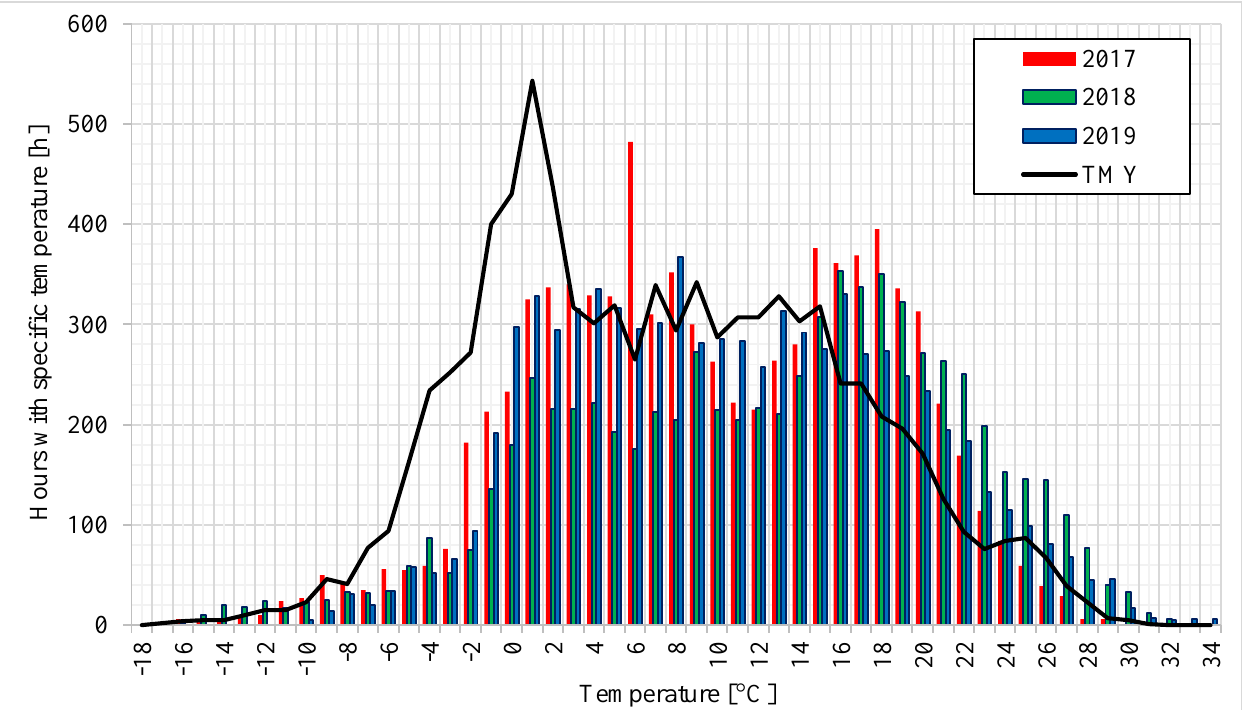
Figure 2. Outdoor temperature histogram.